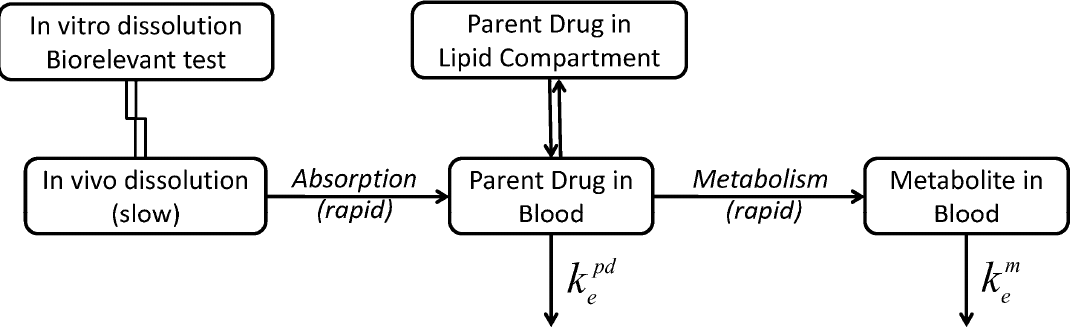
Figure 9. Schematic of processes involved in the pharmacokinetics of drugs that undergo substantial metabolism.